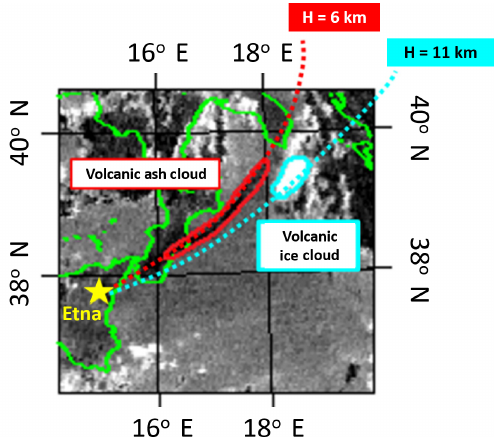
Figure 3. Satellite image (SEVIRI) showing the trajectories of the two volcanic clouds (modified from Fig. 17 in Corradini et al., 2016). The ash cloud dispersed towards the Apulia region (southern Italy) at ∼ 6kma.s.l., whereas the ice/gas cloud moved over Alba- nia at ∼ 11kma.s.l.